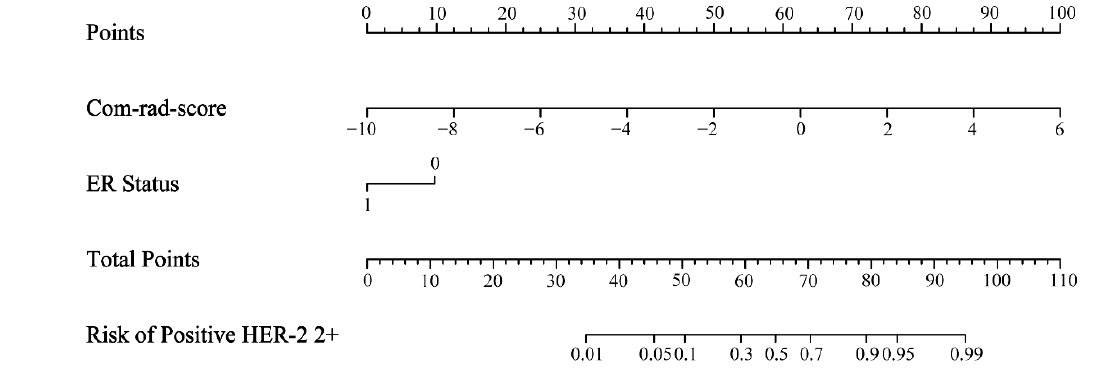
Figure 5. Radiomics nomogram incorporating the com-rad-score and ER status.